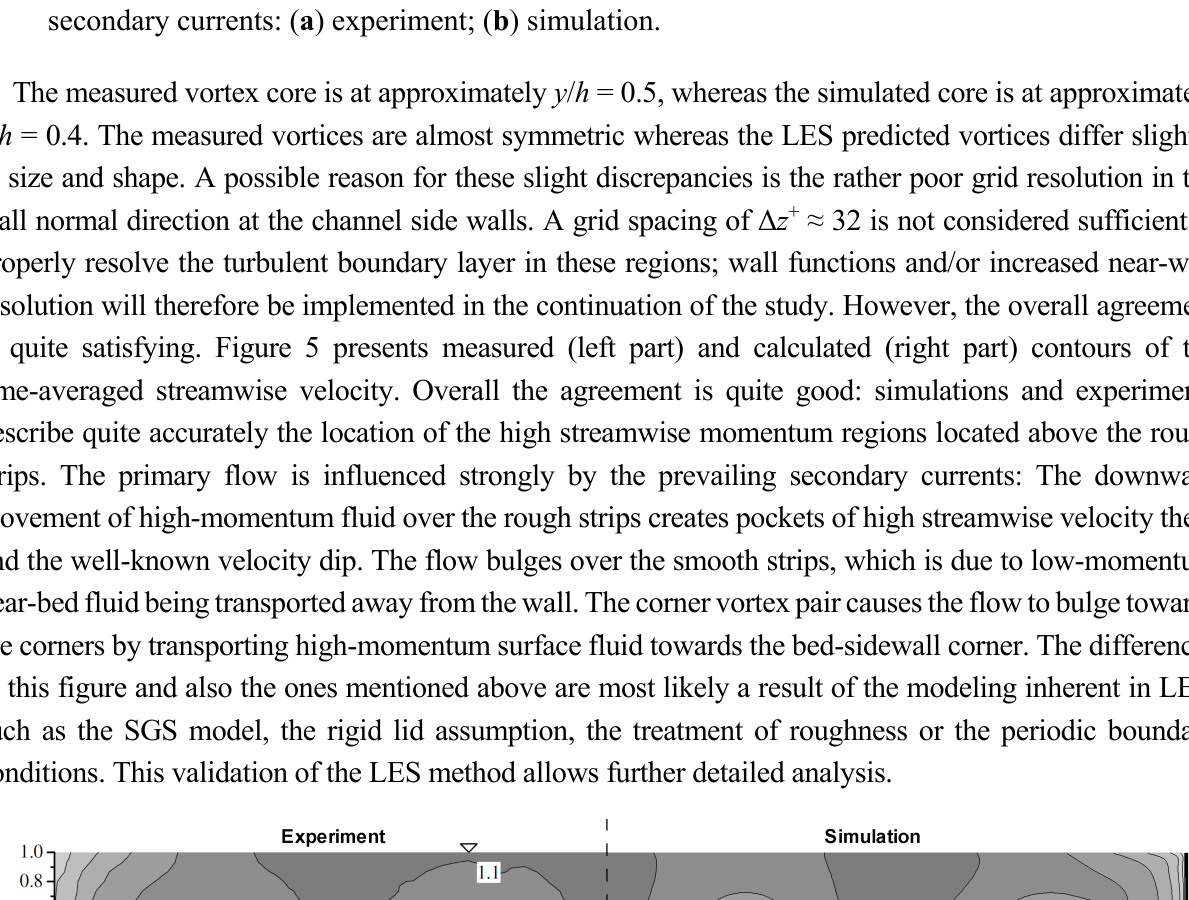
Figure 4. Streamwise-averaged velocity vectors in the vertical-spanwise plane, showing secondary currents: ( a ) experiment; ( b ) simulation.